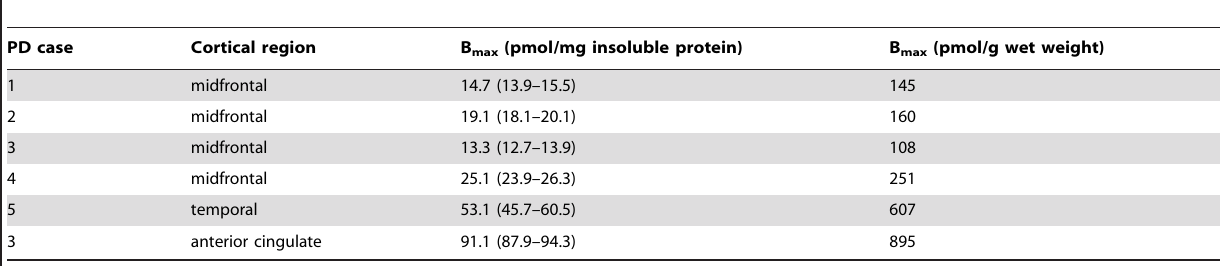
Table 5. B max values determined in saturation binding studies with PD brain tissue samples.